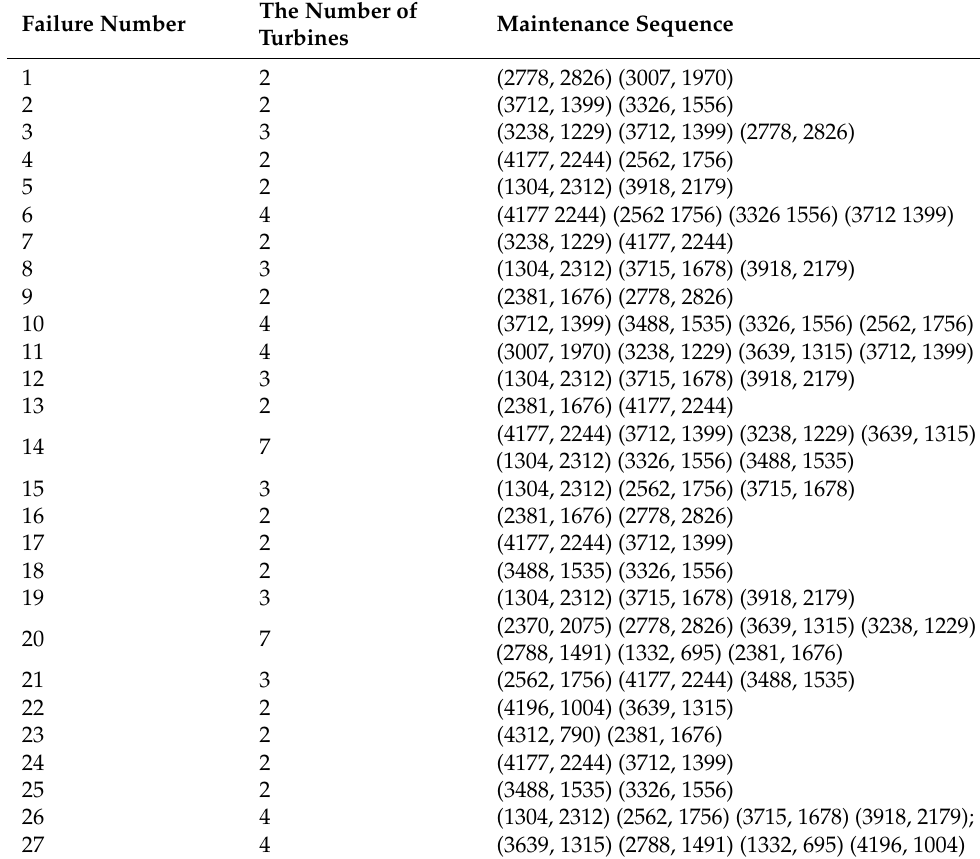
Table 8. The maintenance optimization based on the improved SA algorithm.